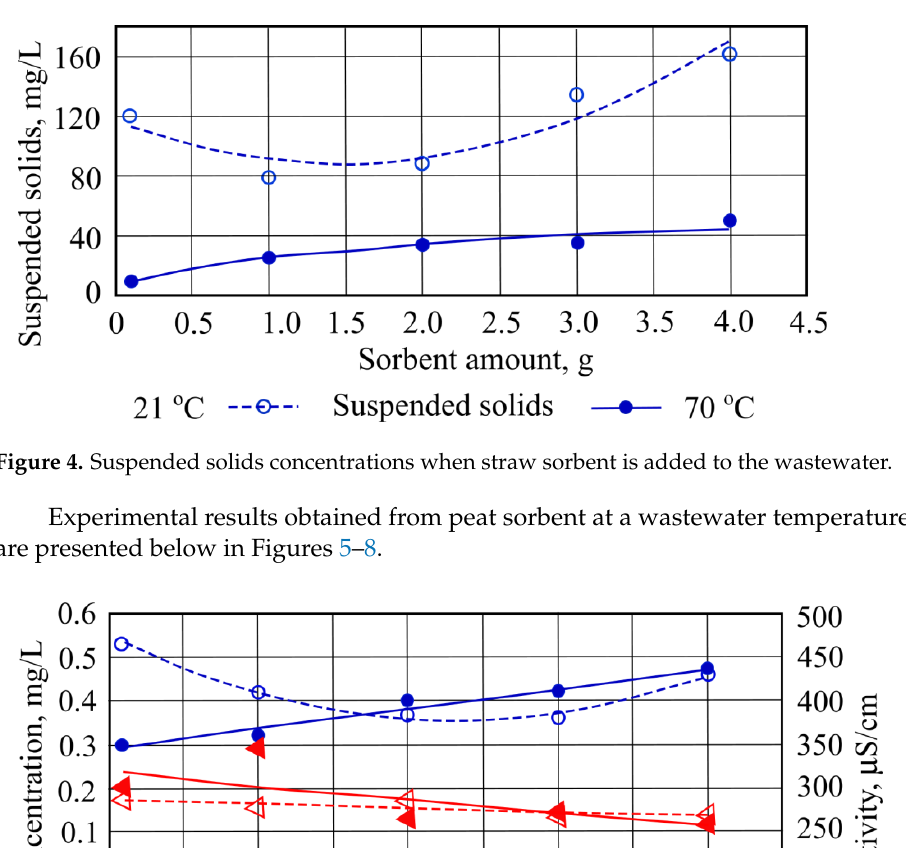
Figure 4. Suspended solids concentrations when straw sorbent is added to the wastewater.